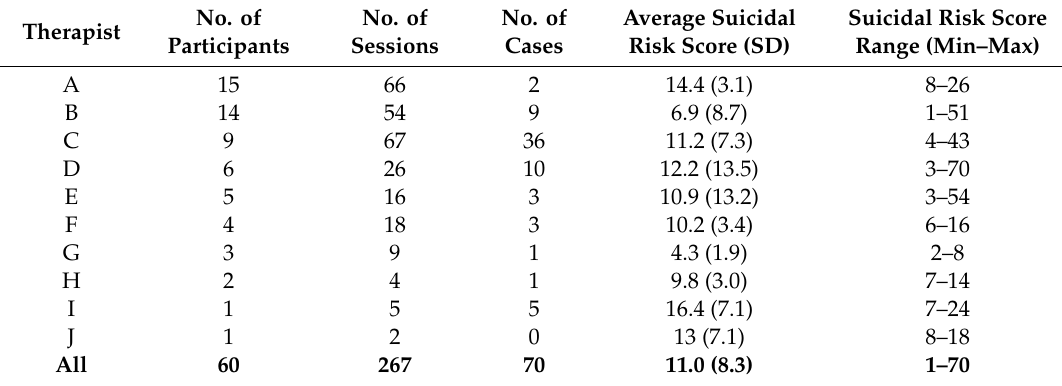
Table 6. Summary of therapist suicidal risk scores, participants, and